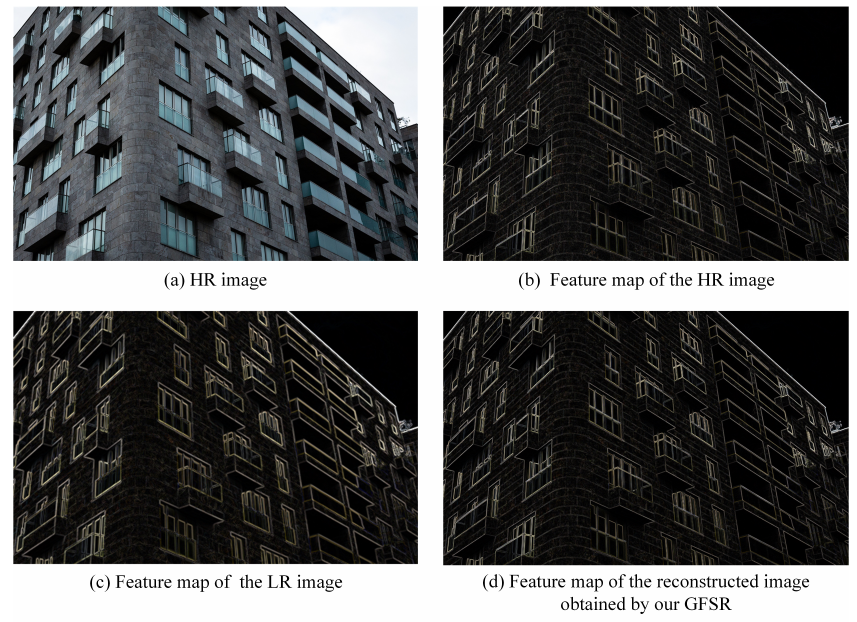
Figure 6. Visualization of the feature map of Img_001